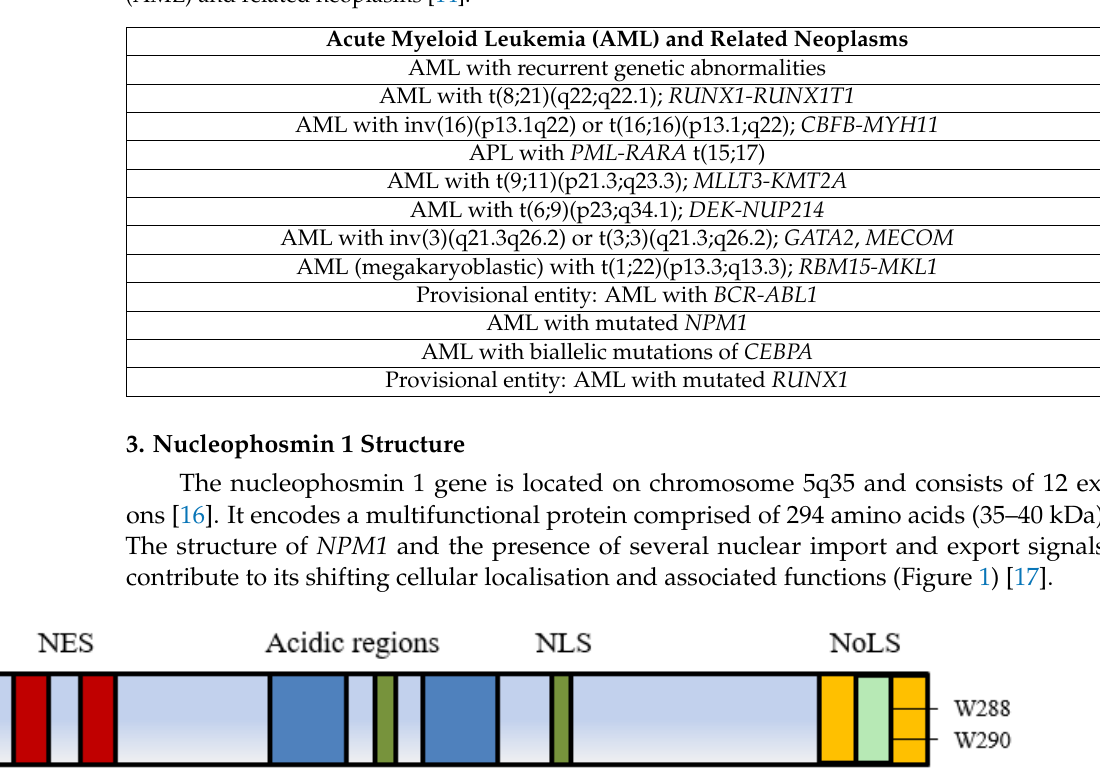
Table 1. The 2016 revision of World Health Organisation classification of acute myeloid leukaemia (AML) and related neoplasms [14].